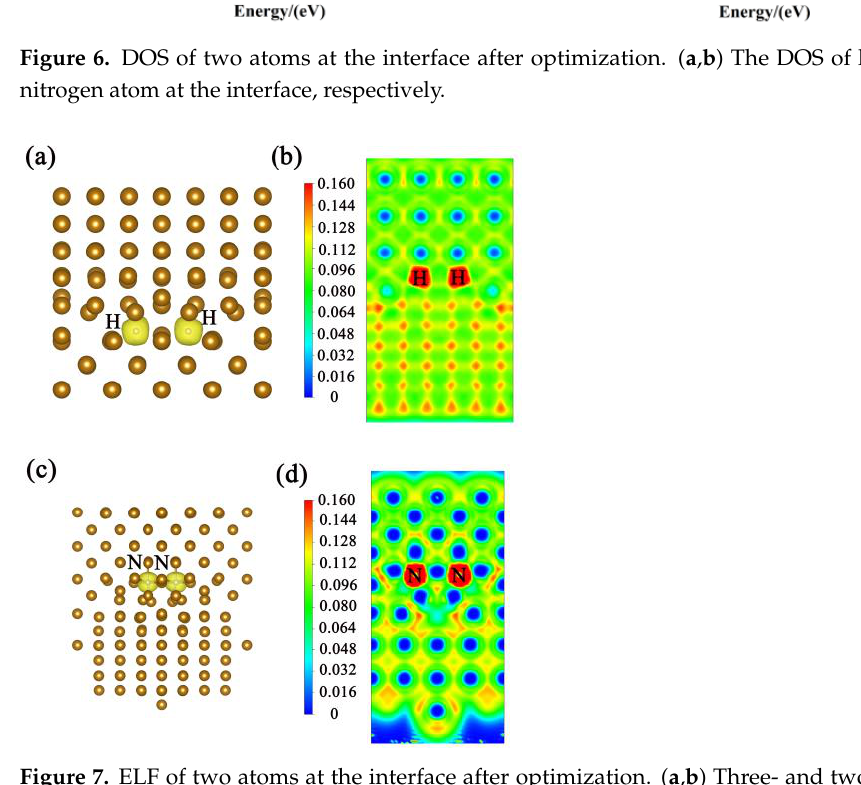
Figure 7. ELF of two atoms at the interface after optimization. ( a , b ) Three- and two-dimensional section view of ELF of two hydrogen atoms at the interface, respectively. ( c , d ) Three- and two-dimensional section view of ELF of two nitrogen atoms at the interface, respectively.